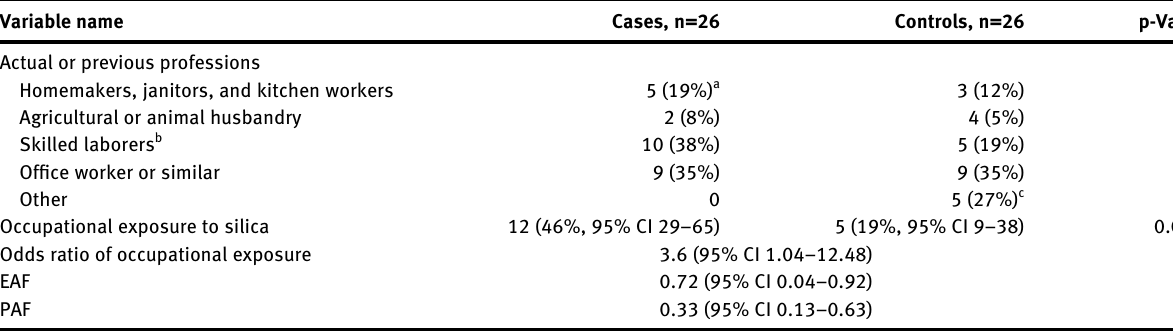
Table  : Distribution of occupations among subjects with active working age (< 